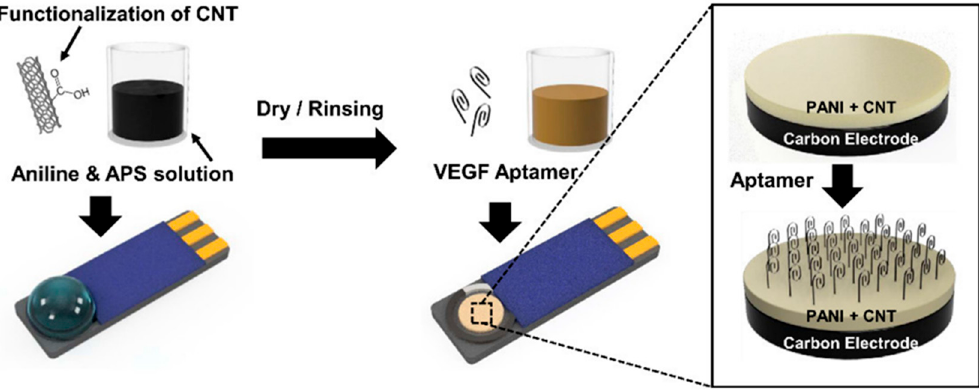
Figure 5. Schematic illustration showing the fabrication of nano-sensor device: preparation of nanocomposite of PANI/CNT and assembly of aptamer VEGF on the sensor surface. Image reproduced with permission from [139].